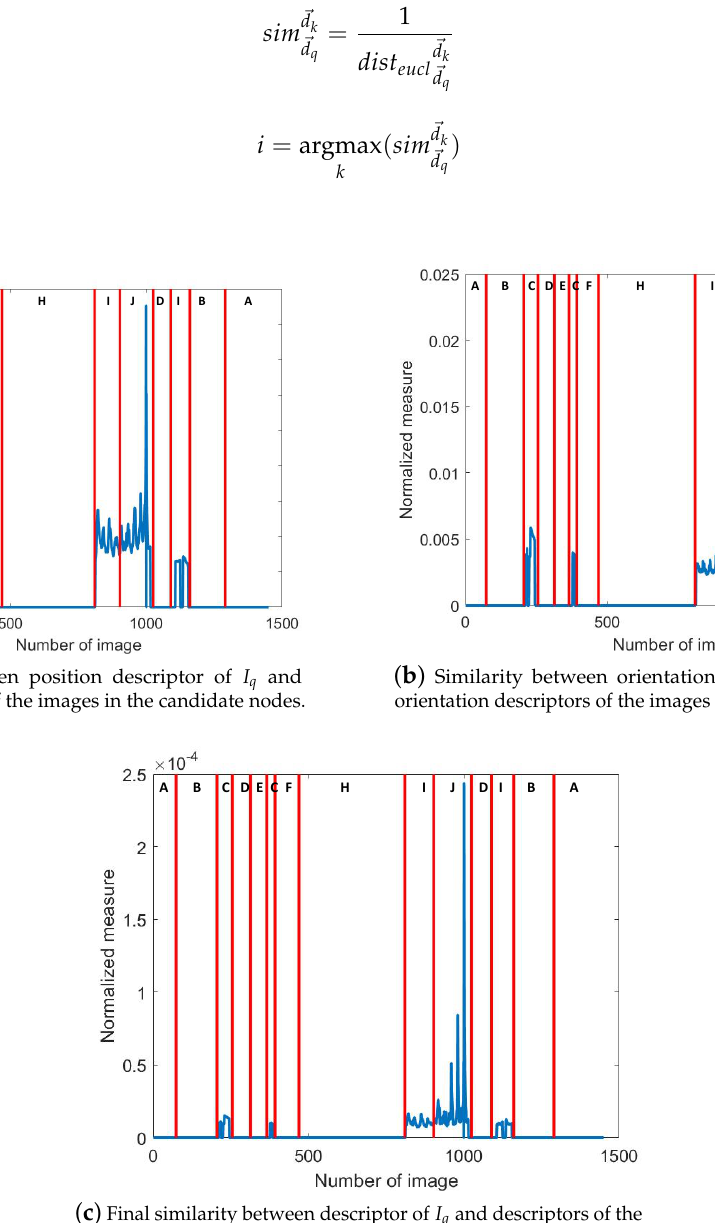
Figure 6. Node Level Loop Closure process example. The node labels are arranged along the top of each subfigure. In this example, the Node Level Loop Closure process has previous retrieved nodes C, I and